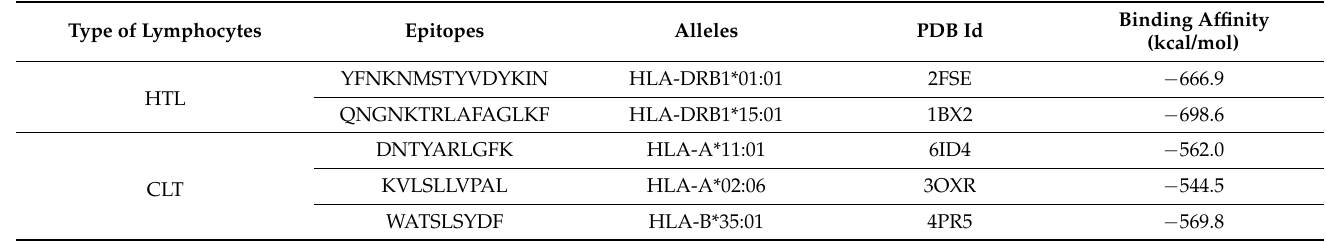
Table 4. Molecular Docking of T-lymphocyte epitopes with corresponding MHC alleles and their binding